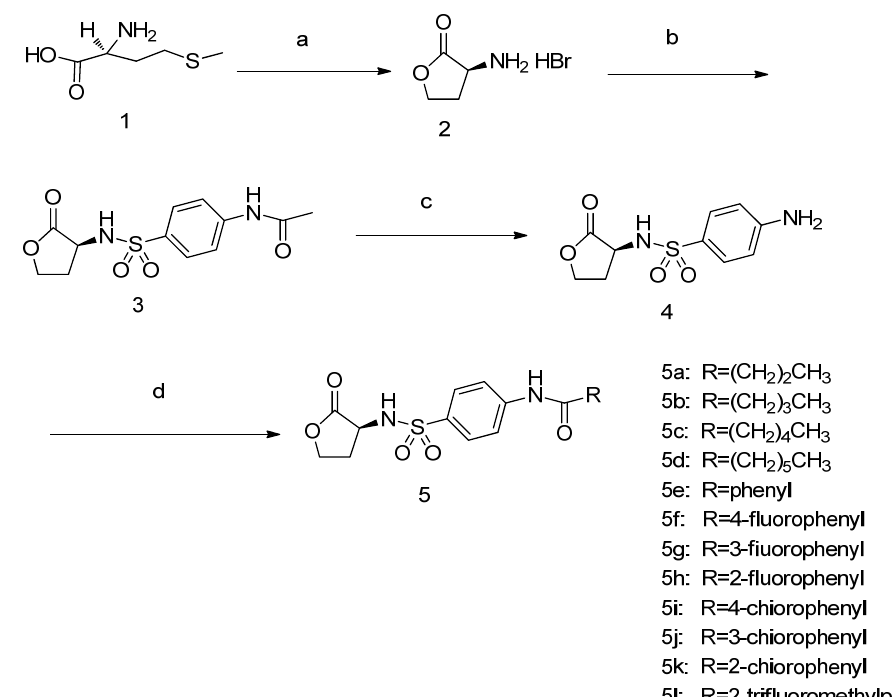
Scheme 1. Synthesis of target compounds.